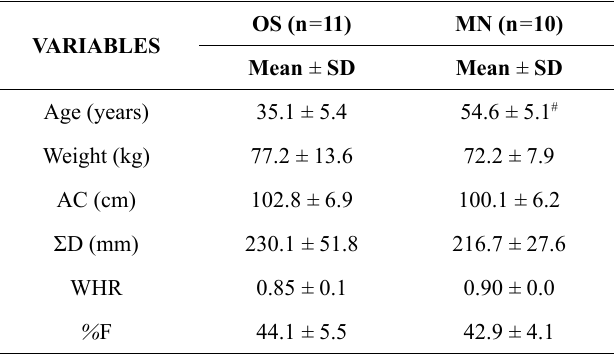
Table 1 - Initial values of the variables of age, weight and anthropom- etry of volunteers in ovulatory and postmenopausal